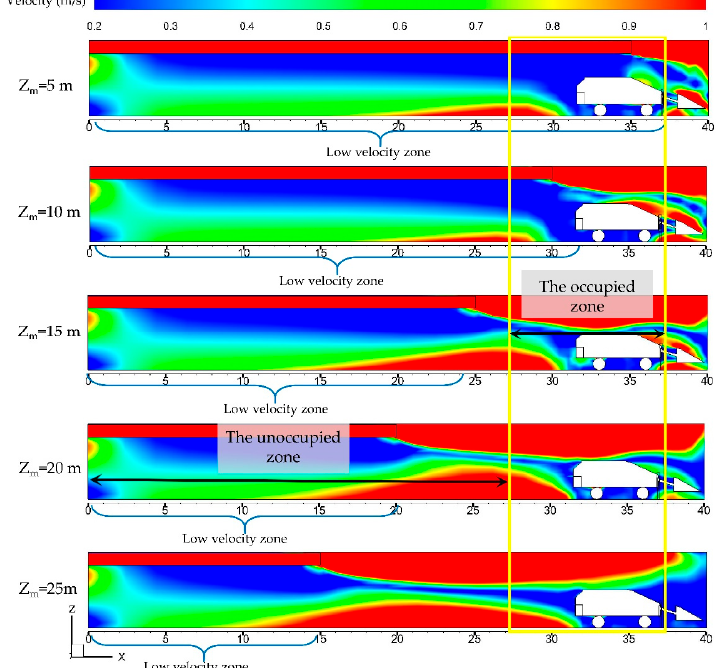
Figure 14. Airflow velocity distributions in plane A when Z m = 5 m, Z m = 10 m, Z m = 15 m, Z m = 20 m, and Z m = 25 m.